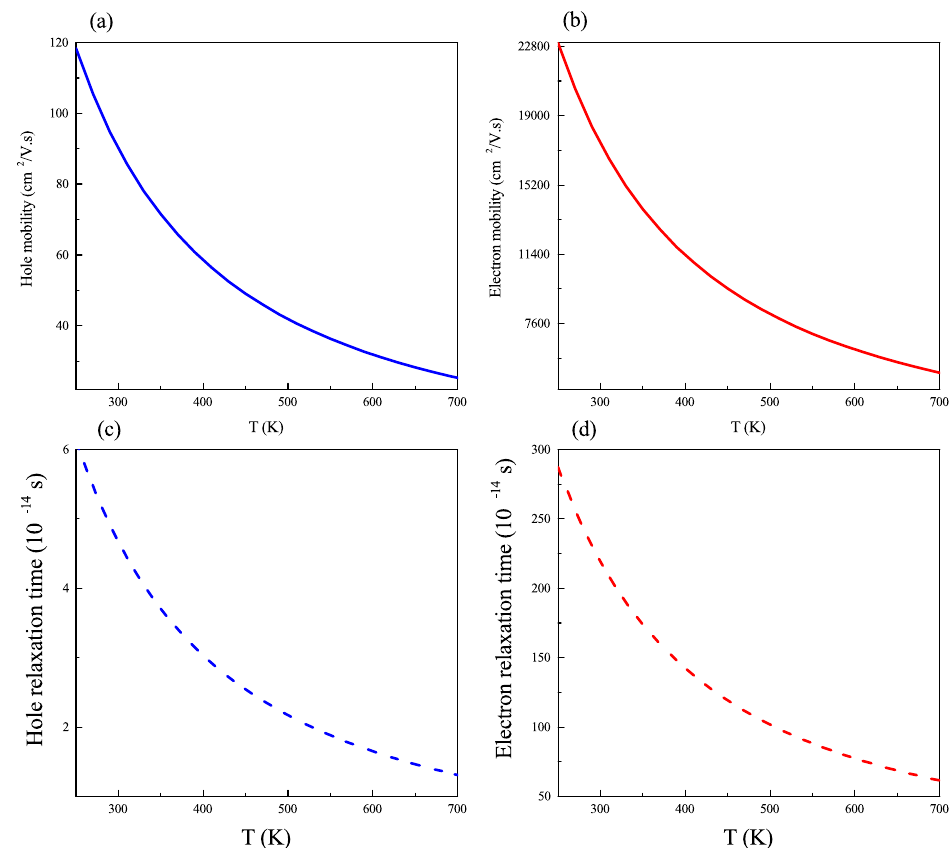
Figure 5. ( a ) Hole mobility; ( b ) electron mobility; ( c ) relaxation time of hole; and ( d ) relaxation time of electron as a function of temperature in kesterite Cu 2 ZnGeS 4